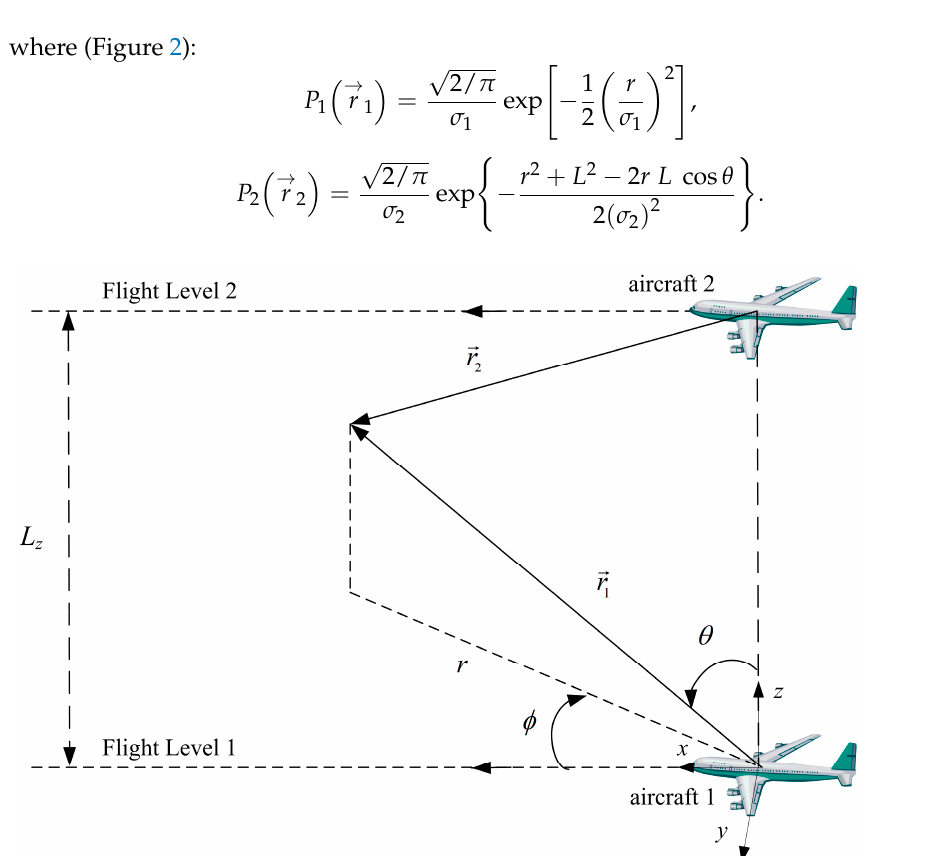
Figure 1. Using spherical coordinates ( r , θ , φ ) with origin on aircraft one, and polar axis along the flight path, the probability of coincidence depends on ( r , θ ) but not on φ , because the configuration is axisymmetric around the flight path.